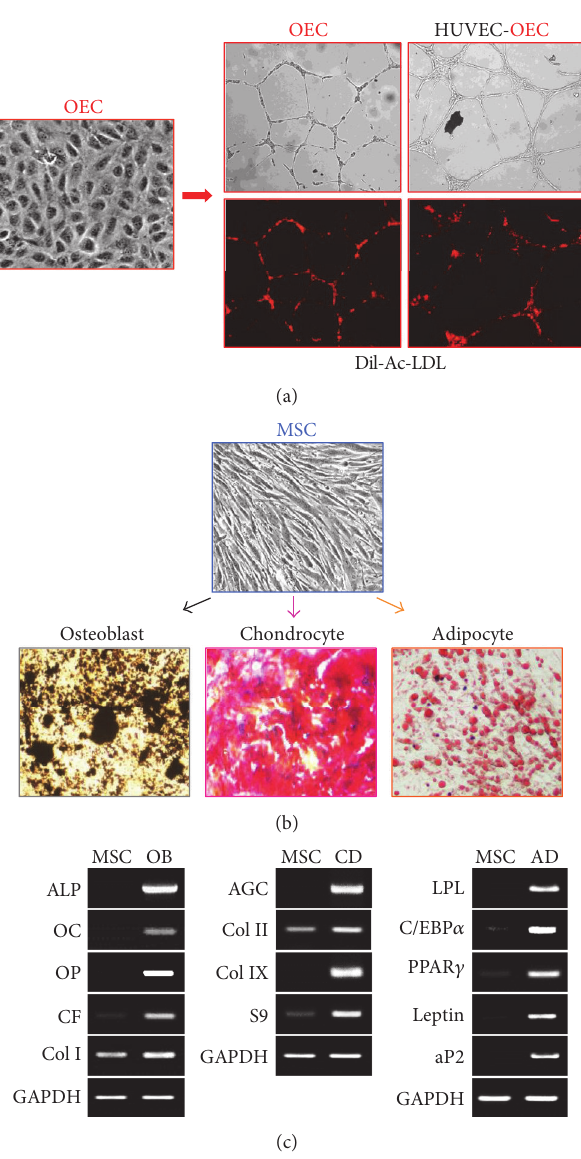
Figure 6: Functional characterization of OECs and MSCs. (a) Imaging of Dil-Ac-LDL-labeled OECs cultured on Matrigel-coated wells demonstrating capillary-like structure formation. (b) After incubation for 2-3 weeks in each differentiation medium, MSCs stained positively for calcium deposition (von Kossa staining), chondrocyte matrix (safranin-O staining), and lipid vacuoles (Oil Red O staining), indicating osteogenic, chondrogenic, and adipogenic differentiation, respectively. (c) Total mRNA was isolated from osteoblasts, chondrocytes, and adipocytes, and specific marker gene expression profiles were assessed by RT-PCR. OB: osteoblast, CD: chondrocyte, and AD: